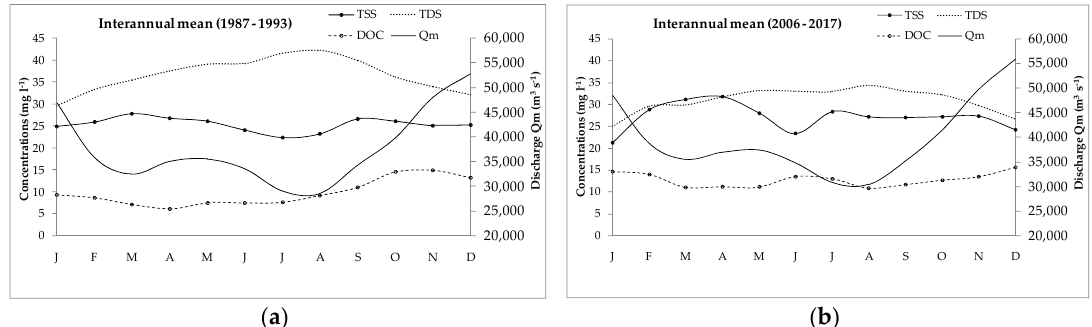
Figure 5. The annual variation of interannual monthly concentrations of total suspended sediment (TSS), total dissolved solid (TDS) and dissolved organic carbon (DOC) (on left axis) at the Congo River Outlet related to the interannual monthly discharge (Q) (on right axis), for ( a ) the PEGI period (1987–1993) and ( b ) the SOH period (2006–2017).